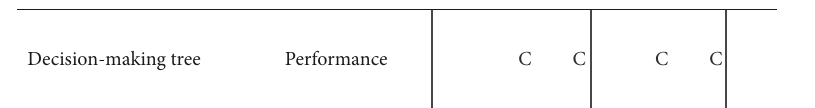
real-time database. Formula (4) is used to obtain